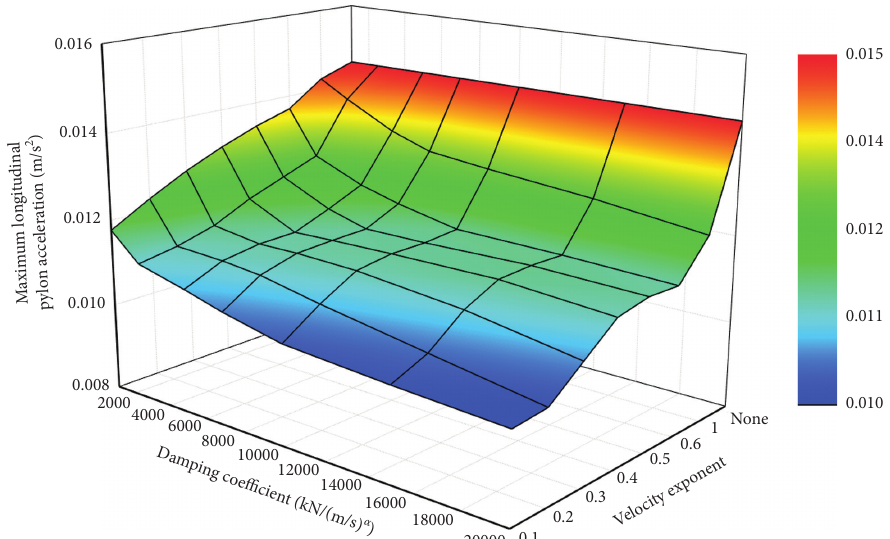
Figure 20: Maximum longitudinal pylon acceleration a